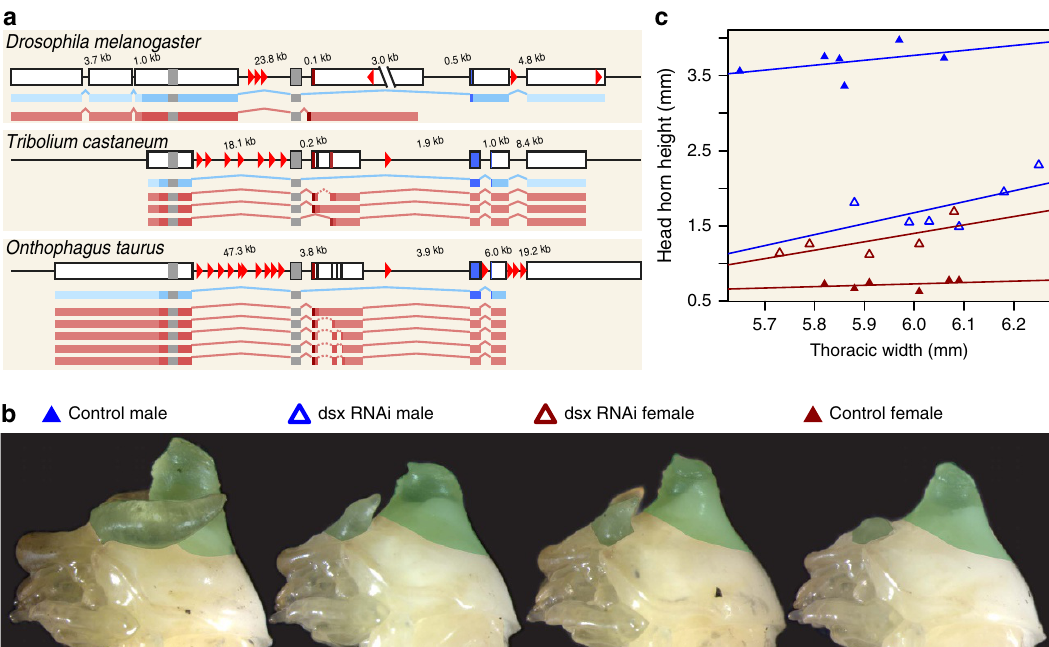
Figure 1 | dsx genomic structure and RNAi phenotypes. ( a ) Genomic structure and isoforms of dsx in the fruit fly Drosophila melanogaster (Diptera; top), red flour beetle Tribolium castaneum (Coleoptera: Tenebrionidae; middle) and bull-headed dung beetle Onthophagus taurus (Coleoptera: Scarabeidae; bottom). Each gene is composed by several exons (black-border boxes) connected by intronic sequences (black line). Male (blue bars) and female (pink bars) isoforms are shown below each gene; within each isoform, a darker hue indicates the coding sequence, the two grey regions represent parts of the OD1 (leftmost) and OD2 (rightmost) domains that are common across all isoforms, and the darkest regions represent sex-specific regions of the OD2 domain. Solid lines in each isoform represent canonical splice junctions; dashed lines indicate non-canonical splicing within a female-specific exon (in beetles). Red arrowheads show positions of putative dsx -binding sites. Exons are drawn to scale; introns are not to scale, but their sizes are indicated above each intron. ( b ) Representative individuals showing the pupal phenotype after sham control dsRNA injection (leftmost: male; rightmost: female) and OtdsxC dsRNA injection (centre left: male; centre right: female). Head horn and thoracic horn tissues dissected for RNAseq false coloured in green. ( c ) Head horn size of the pupae used for dissection, plotted against pupal weight. OtdsxC dsRNA injection (open triangles) reduces head horn size in males (blue triangles) but induces head horn growth in females (red triangles) compared to sham controls (filled triangles).